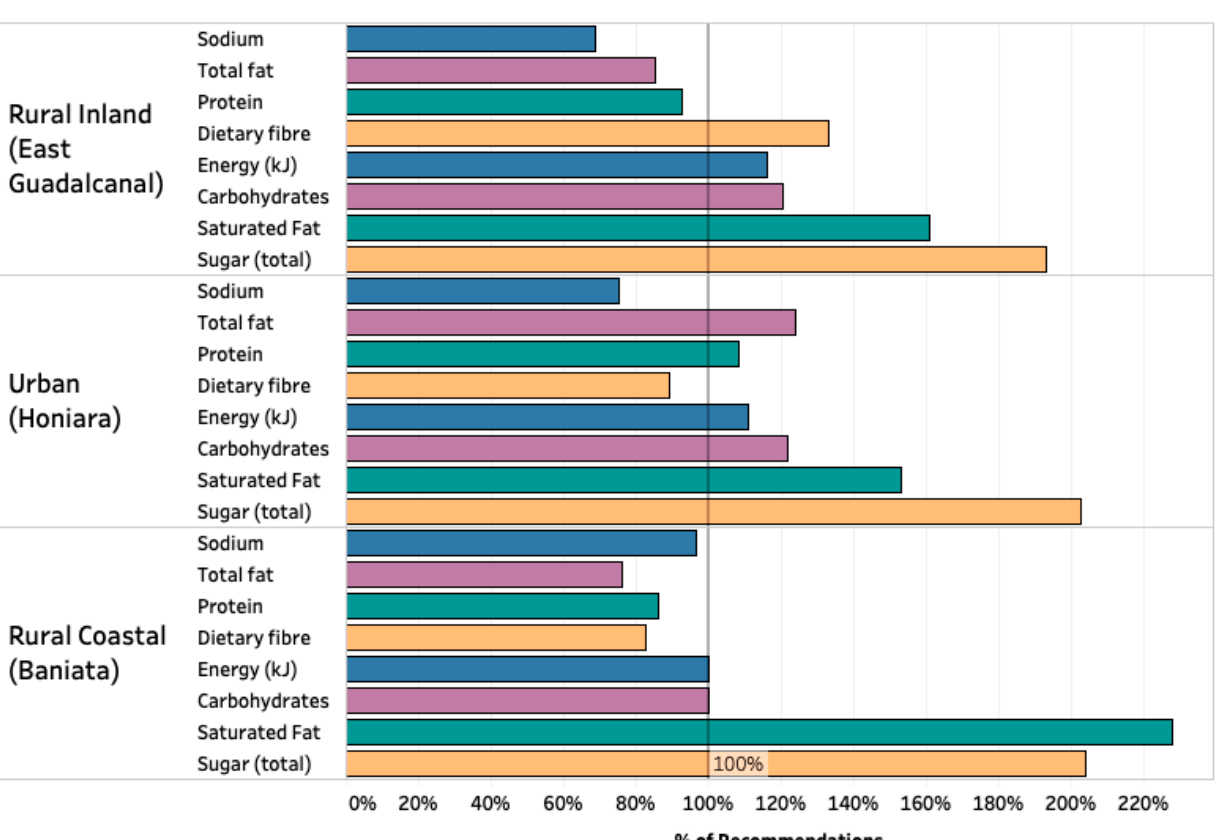
Figure 3. Macronutrient intakes compared with dietary recommendations in three geographically distinct food systems ( n = 94). Energy requirements were compared to total energy expenditure (TEE) from basal metabolic rate (BMR) + physical activity level (PAL). Total fat recommendations <30% total kcal and saturated fat recommendations <10% of total kcal [33]. Sugar limits are sourced from WHO guidelines (2015) and salt limits from American Heart Association guidelines (2020).